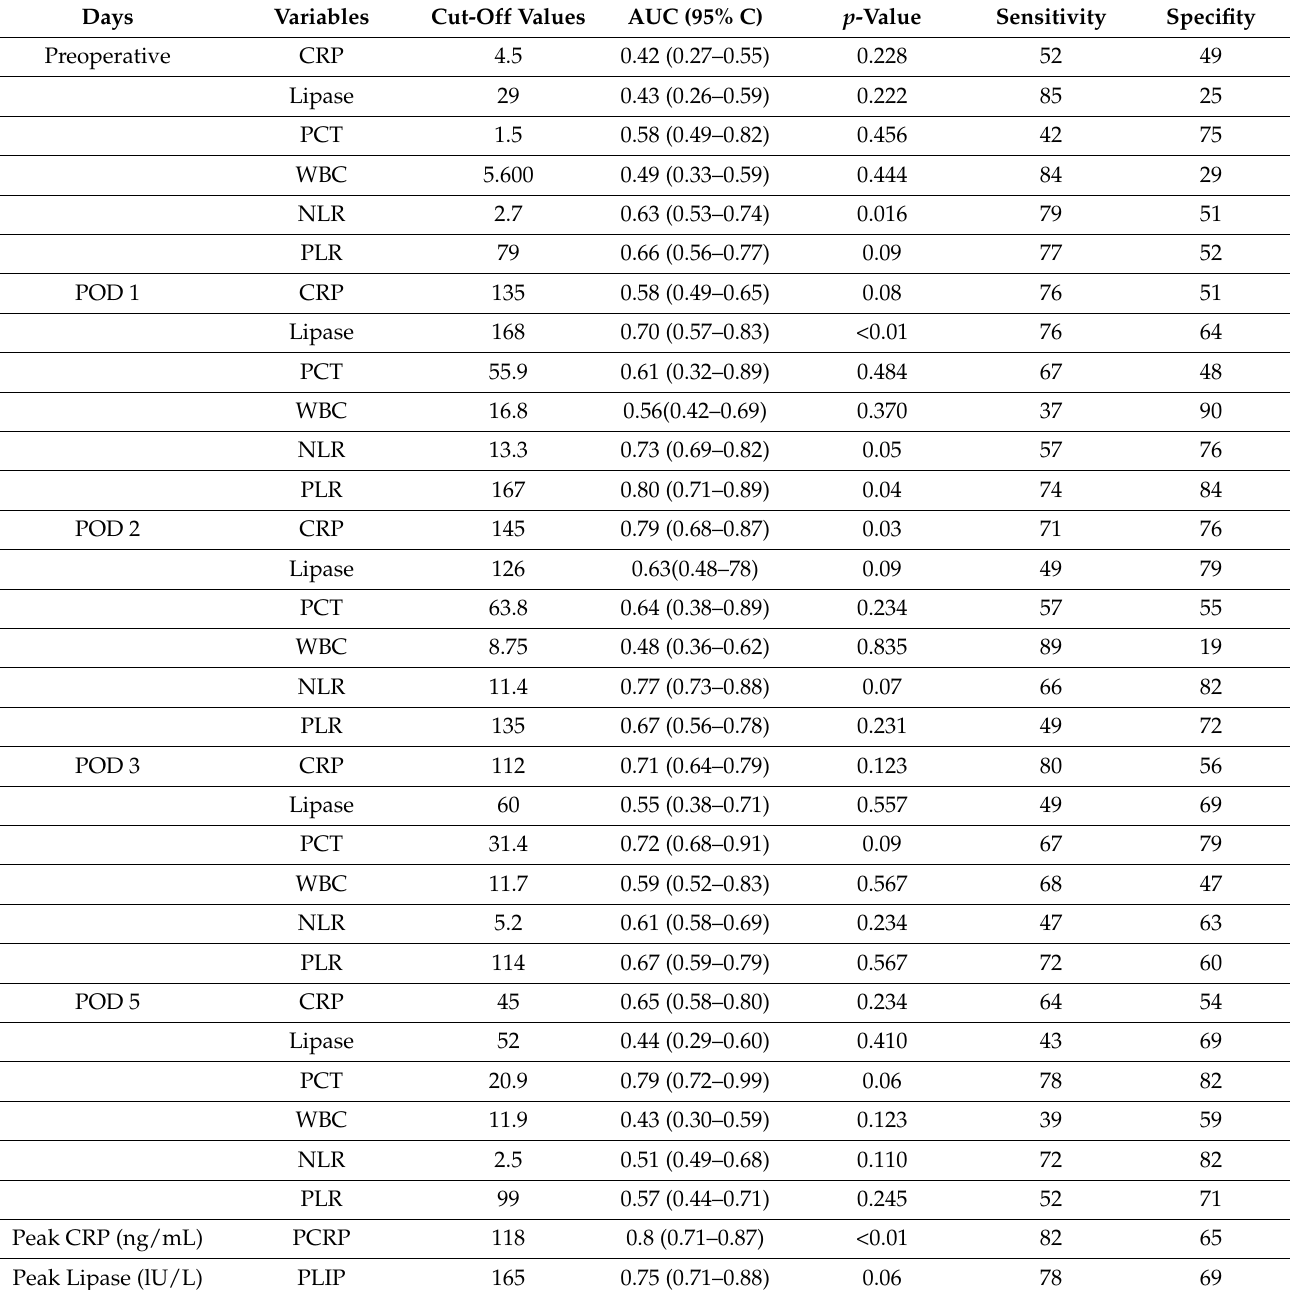
Table 5. ROC analysis of different serum markers for the prediction of early renal graft dysfunction following simultaneous pancreas–kidney